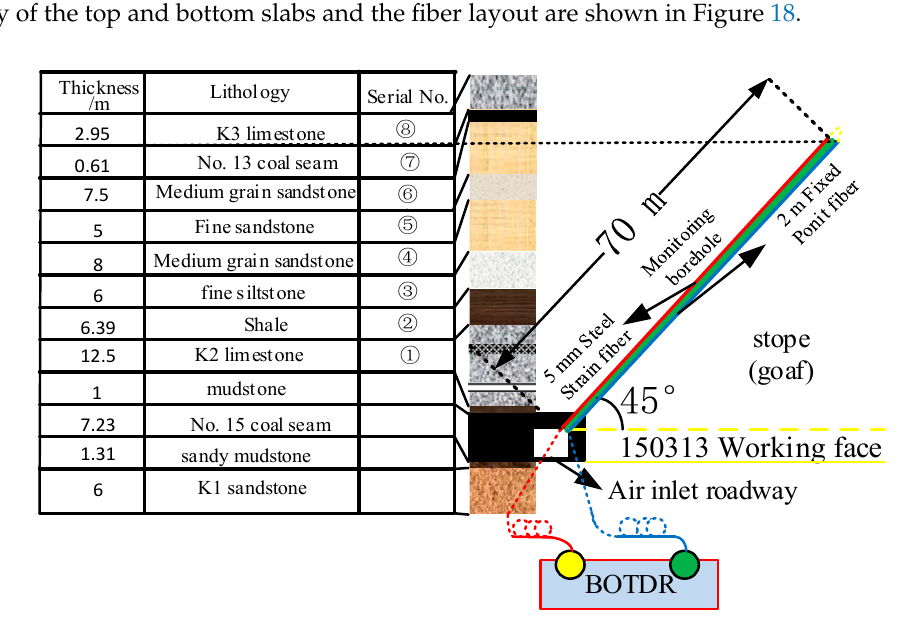
Figure 18. Optical fiber layout and roof/bottom rock formations.